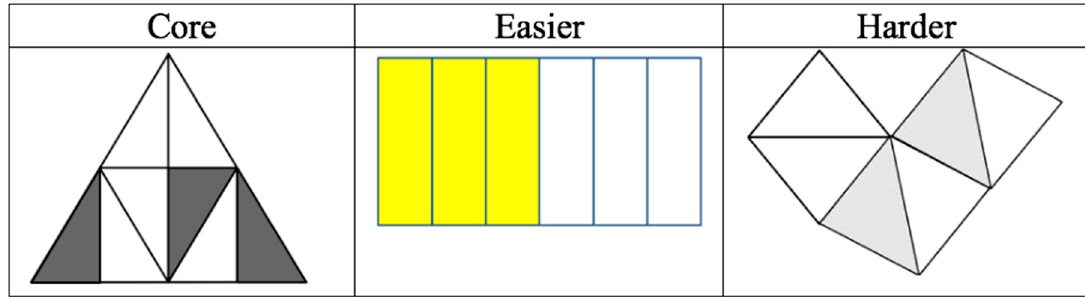
Figure 5. Examples in which an entire composite figure serves the reference unit so that the figure represents a proper fraction only.